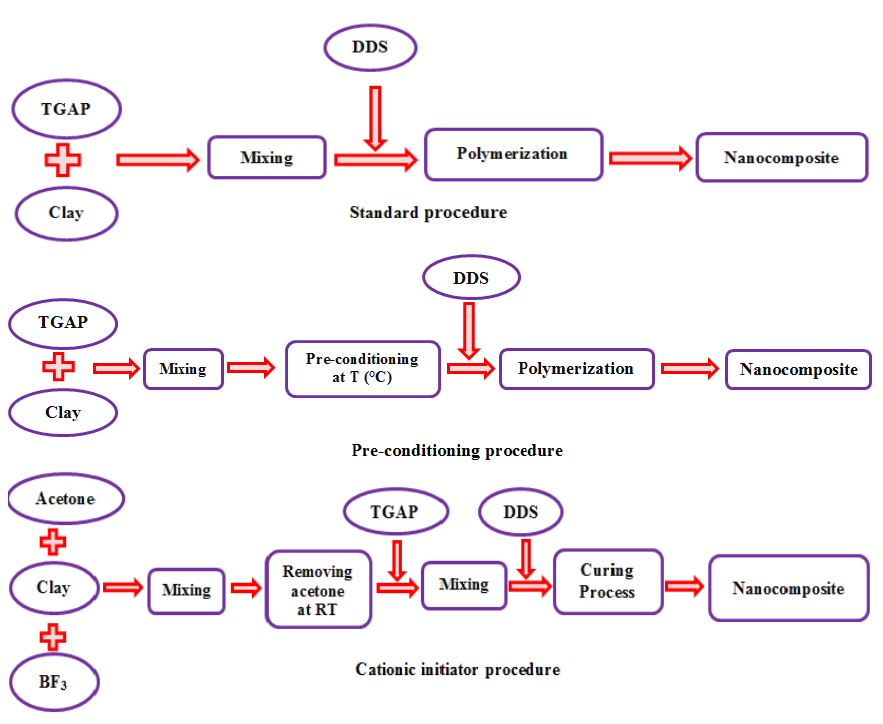
Figure 1. Schematic illustration of the different nanocomposite preparation